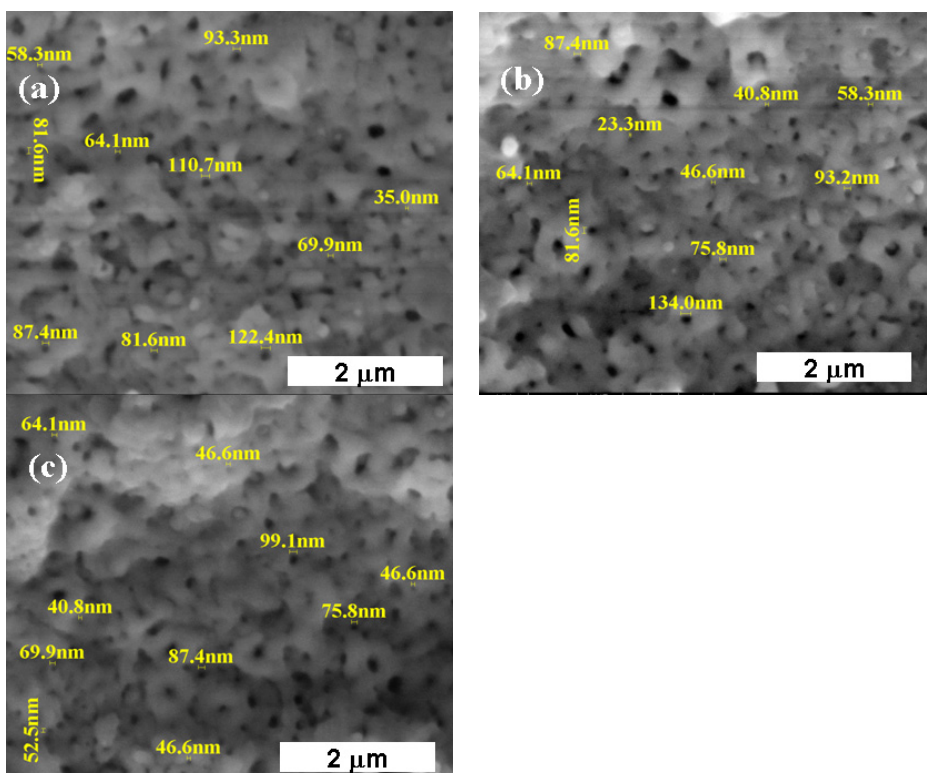
Figure 5. Morphological and dimensional analysis of the titanium oxide (TiO 2 ) film nanopores formed on the surface of the titanium alloy depending on the oxidation time at a potential of 200 V: ( a ) nanopores formed on Ti6Al4V alloy with an oxidation time of 1 min, ( b ) nanopores formed on Ti6Al4V alloy with an oxidation time of 2 min, and ( c ) nanopores formed on Ti6Al4V alloy with an oxidation time of 3 min.